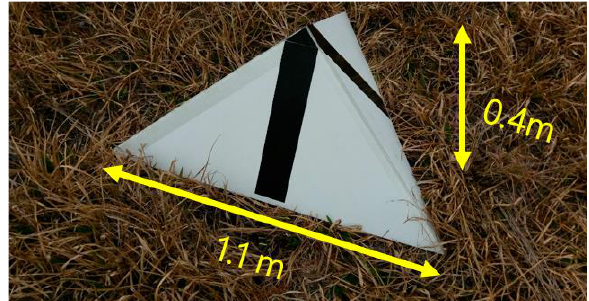
Figure 2. The geometric targets with approximate dimensions when deployed (figure courtesy Wilkinson et al.,